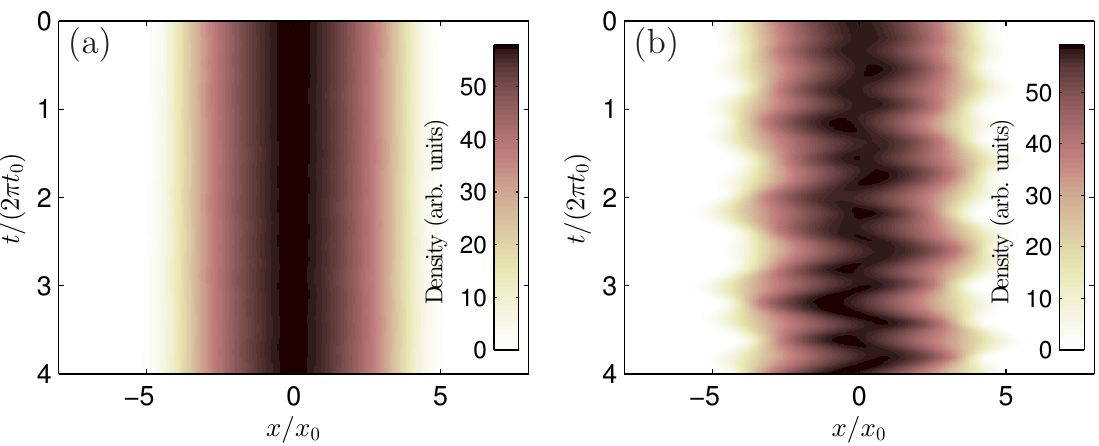
Figure 3. Measurement-induced symmetry breaking of a spatial condensate pattern and the restored symmetry in the ensemble average over many individual realizations of classical stochastic measurement trajectories. ( a ) Ensemble averaged stochastic field density | ψ ( x, t ) | 2 of the BEC response unconditioned on any particular measurement trajectory, formed by ensemble averaging 400 single trajectories. ( b ) A single trajectory that exhibits a typical measurement-induced spatial symmetry breaking, shown here for comparison.